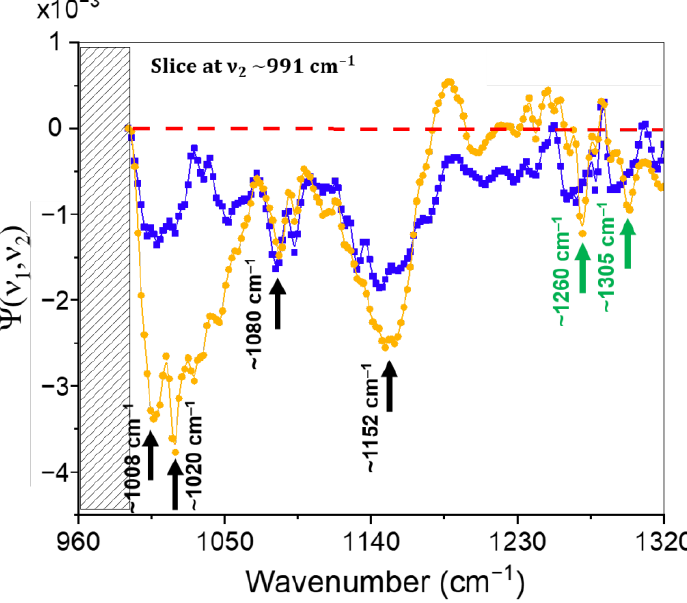
Figure 4. Asynchronous correlation intensity profile calculated along the horizontal slice character- ized by 𝜈 2 ~ 991 cm −1 for Coum/SBE-β-CD inclusion complex (orange circles) and Coum+SBE-β- CD physical mixture (blue squares). The red dashed line accounts for the Ψ(𝜈 1 ,𝜈 2 )~0 condition. Thus, positive and negative correlations develop above and below this line. Considering the region of the 2DAM which satisfies the 𝜈 1 > 𝜈 2 condition (see text for details), information originating from the left-side portion of the 2D map with respect to the diagonal line must be excluded (black hatched bar). Black and green arrows indicate 𝜈 1 values of interest for our discussion.